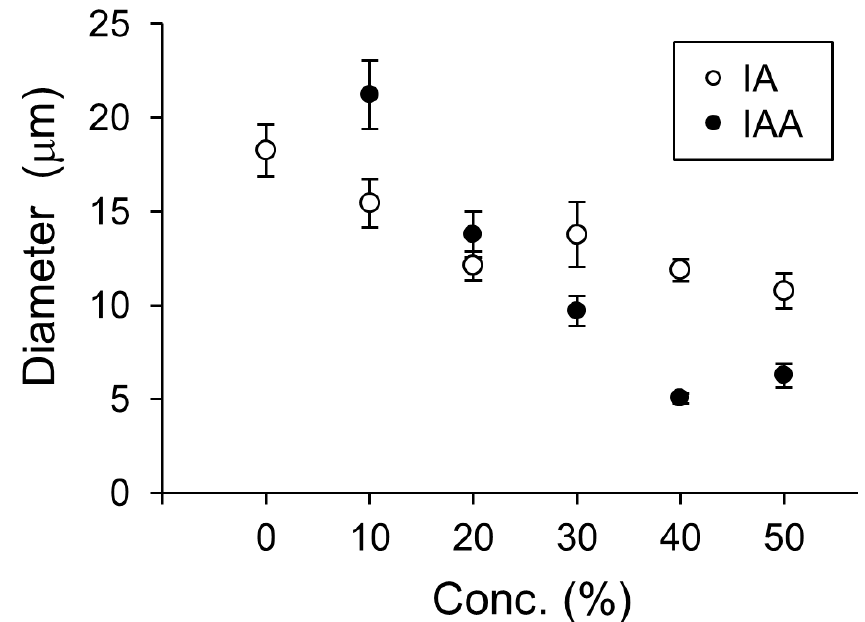
Figure 5. Diameters of vesicles containing isoamyl acetate (IA) or isoamyl alcohol (IAA) at different concentrations (0–50%). Lipid vesicles containing isoamyl acetate (IA, white dots) and isoamyl alcohol (IAA, black dots).